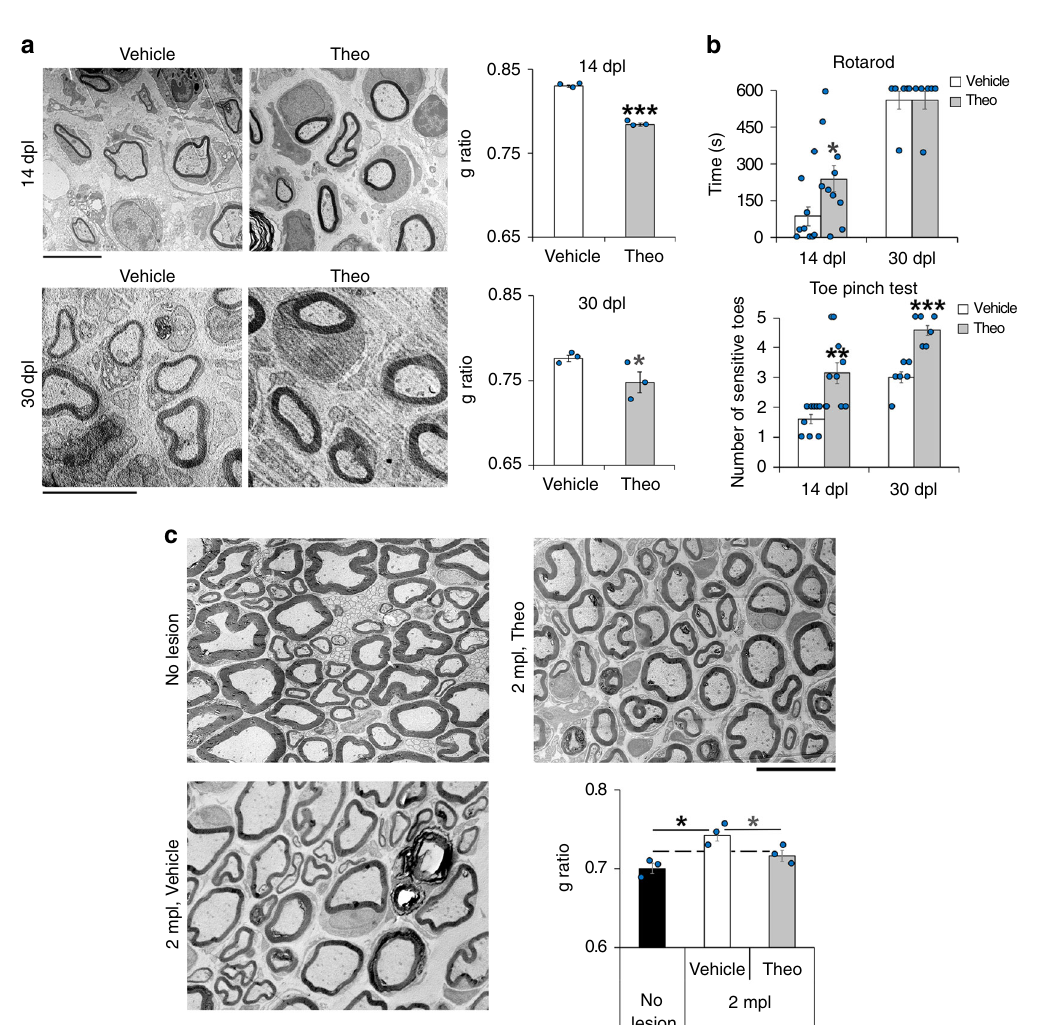
Fig. 8 Theophylline accelerates and enhances PNS remyelination and functional recovery. a , c Electron micrographs of Cr ultrathin sections at 14dpl, 30dpl ( a ) and 2mpl ( c ) from mice treated with theophylline or vehicle at 10dpl for 4 days, and myelin thickness quanti fi cation (g ratio) of remyelinated axons ( n = 3 animals per group per time-point, 14dpl: p = 0.000046, 30dpl: p = 0.048585, 2mpl: pVehicle/No-lesion = 0.013591, pTheo/No- lesion = 0.076193, pTheo/Vehicle = 0.034469). b Quanti fi cation of motor (Rotarod) and sensory (toe pinch) function recovery at 14 and 30dpl in theophylline- and vehicle-treated mice (4-day treatment at 10dpl). 14dpl: n = 9 – 10, pRotarod = 0.02518, pToe-pinch = 0.002327, 30dpl: n = 6 per group, pRotarod = 0.489629, pToe-pinch = 0.000363. Data are presented as mean values ± SEM. Unpaired one-tailed (gray asterisks) or two-tailed (black asterisks) student ’ s t -tests. Scale bars: 5 µ m ( a , b ), 10 µ m ( c ). Source data are provided as a Source Data fi